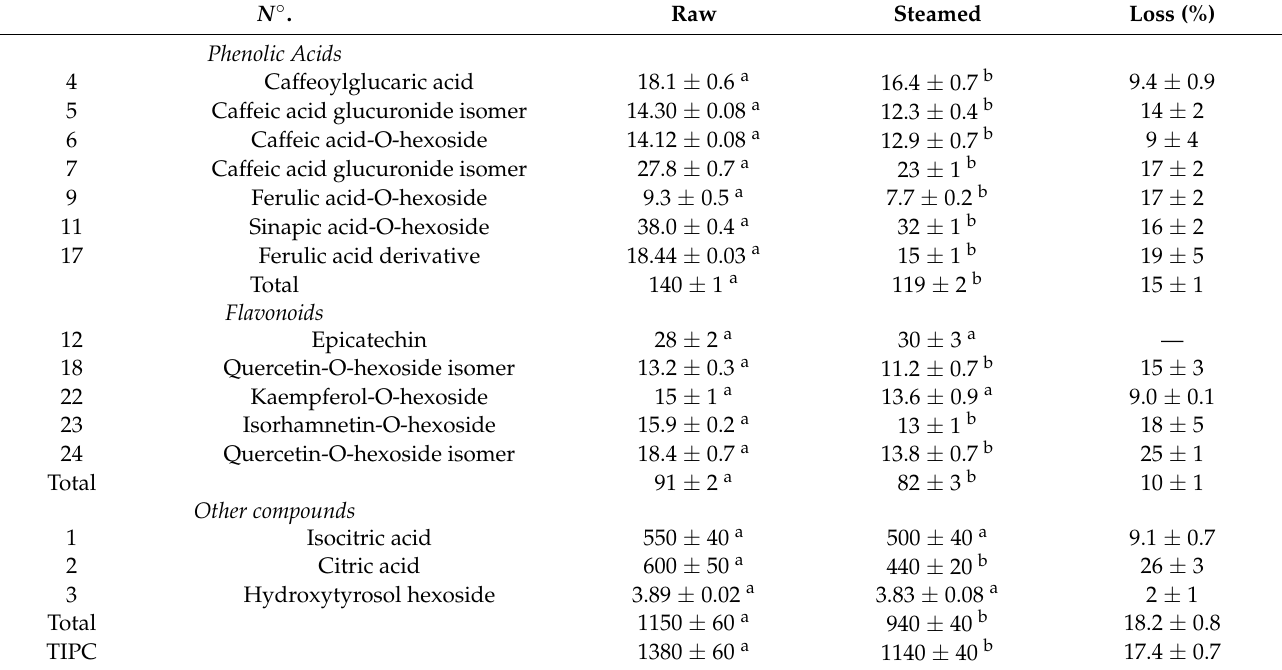
Table 2. Quantification of compounds in raw and steamed extracts of Portulaca oleracea . N ◦